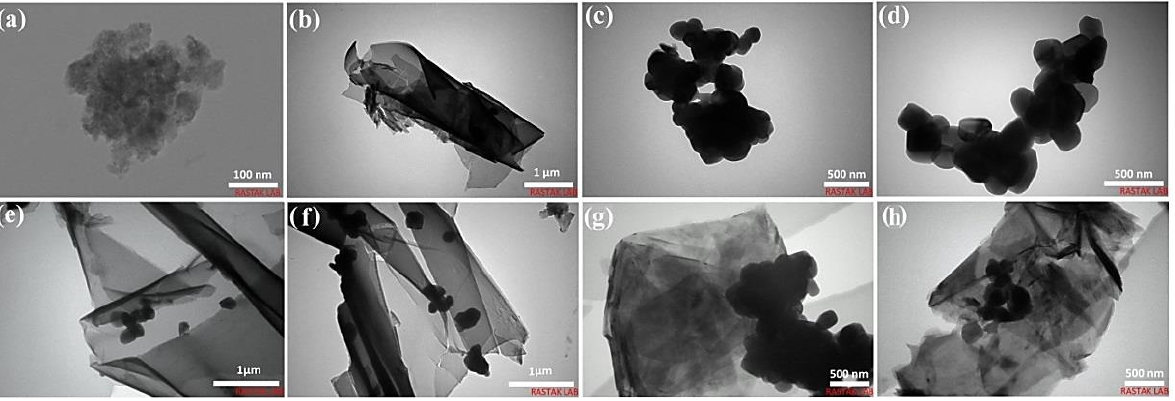
Figure 3. TEM micrographs of ( a ) Mg, ( b ) GO, ( c , d ) Cu, ( e , f ) MZ/GO (G), ( g , h ) MZ/GO-Cu powders.